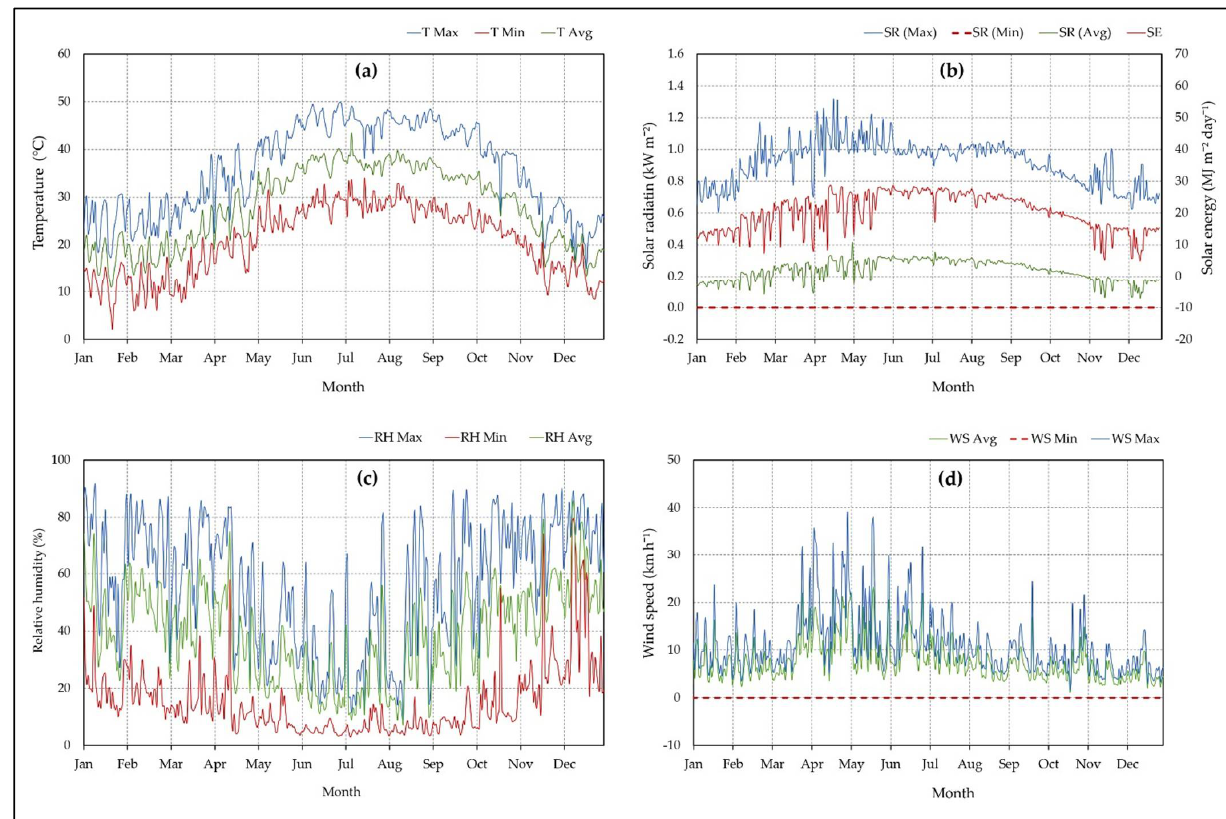
Figure 10. Daily average (Avg), minimum (Min), and maximum (Max) of the temperature ( a ), solar radiation ( b ), relative humidity ( c ), and wind speed ( d ) over the year 2020 in the study area.